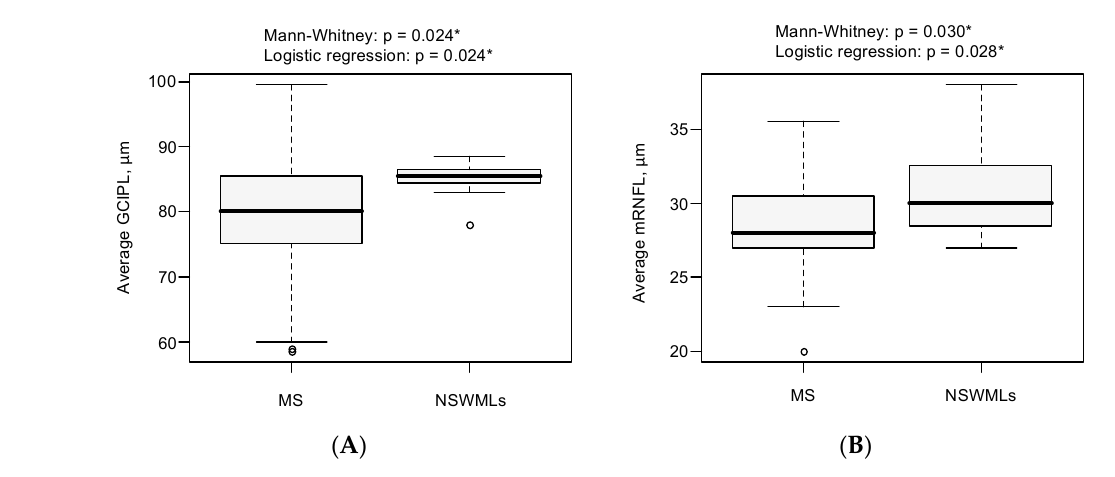
Figure 4 Results of the logistic regression model.